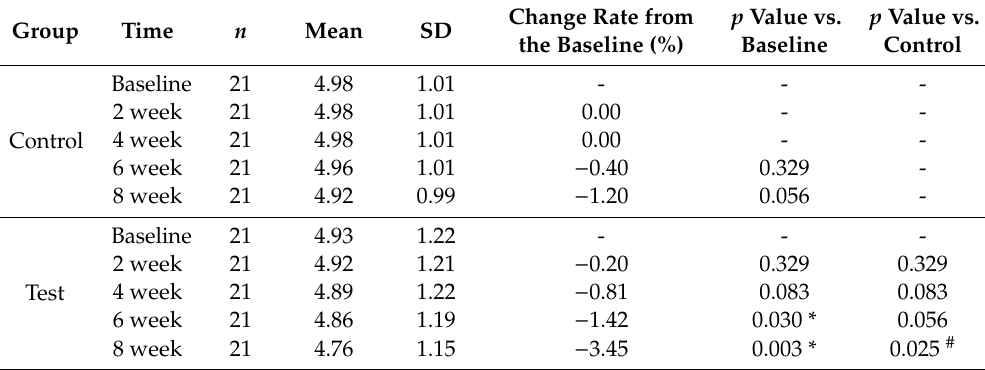
Table 10. Visually assessed degree of skin pigmentation of the control and test groups.